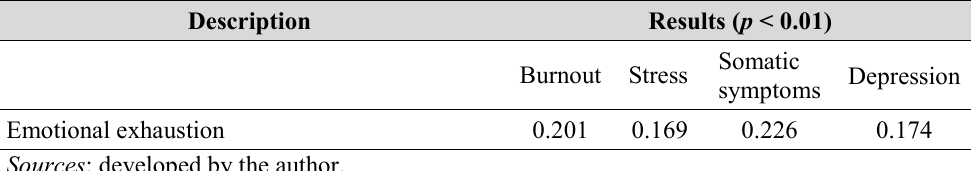
Table 2. Relations between Emotional Exhaustion and Mental Health